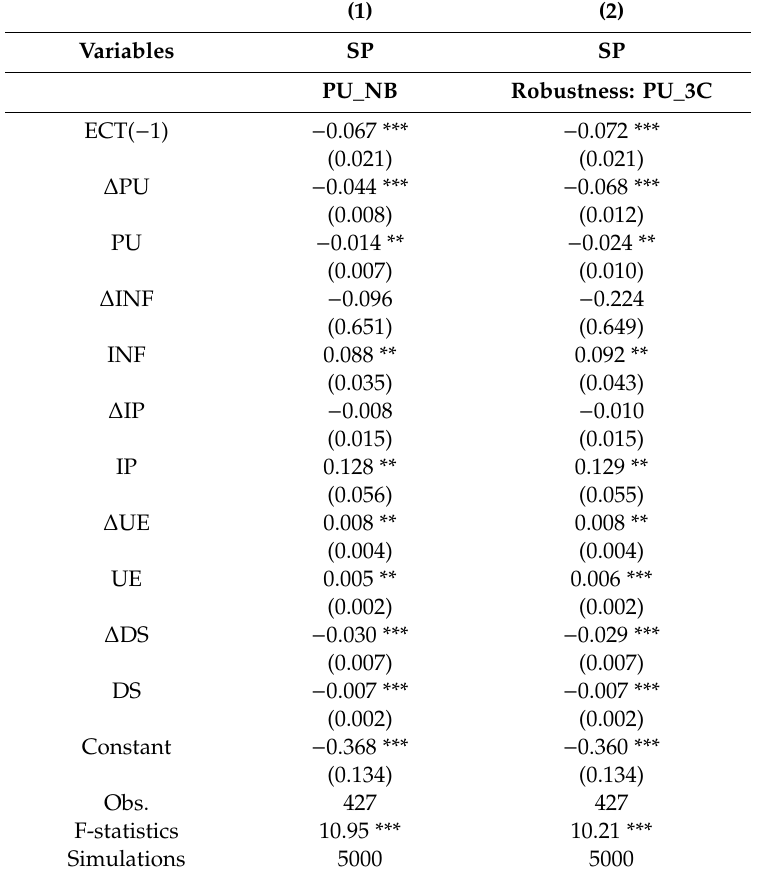
Table 4. Dynamically simulated autoregressive distributed lag (DYS-ARDL)